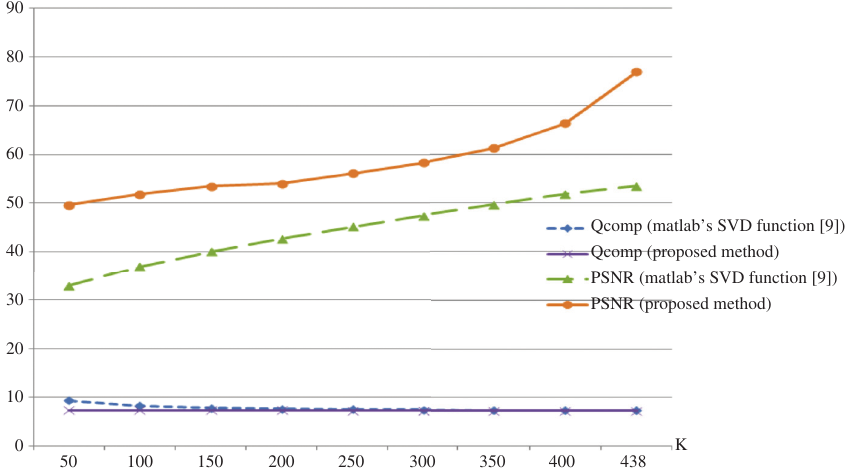
Figure 8: Relation between Image Rank, Compression Ratio, and PSNR for Chrysantheme.jpg, 1024 × 768, 858ko.